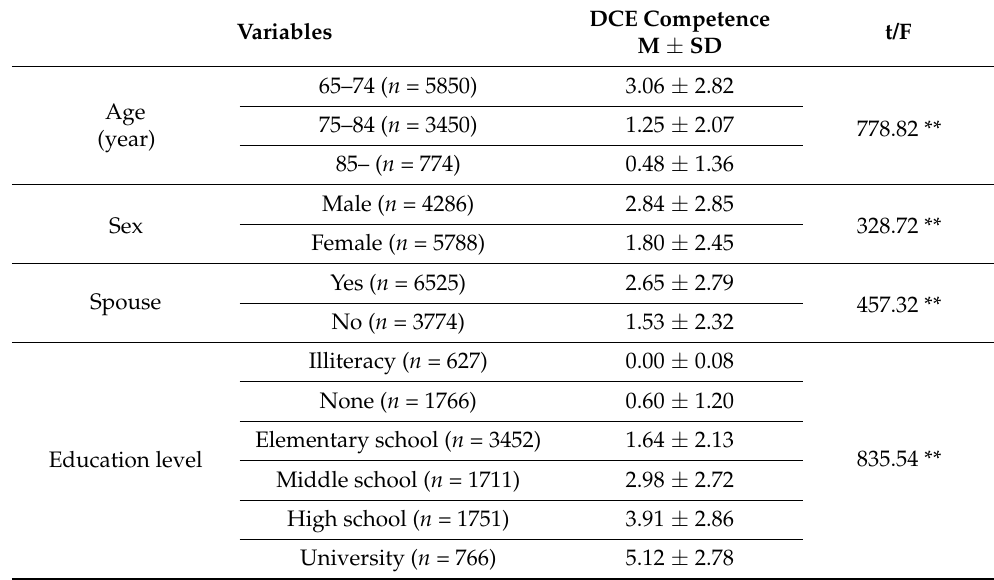
Table 2. DCE competence based on sociodemographic factors ( n =